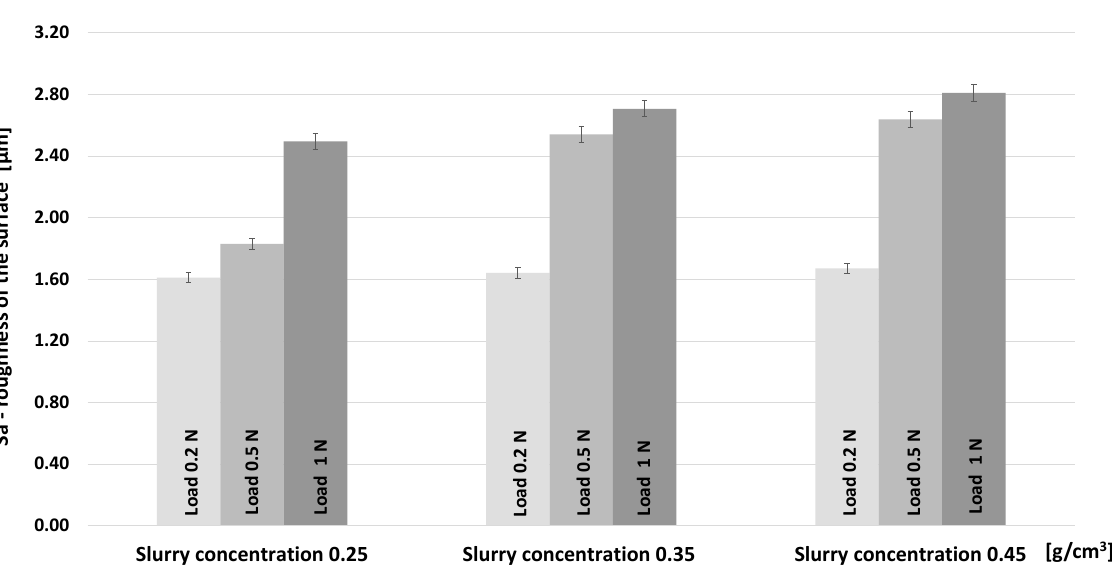
Figure 10. Roughness parameter trends (Sa) of the scars resulting from the micro-scale abrasion tests for the different abrasive slurry concentrations and different loads (0.2 N, 0.5 N and 1N).